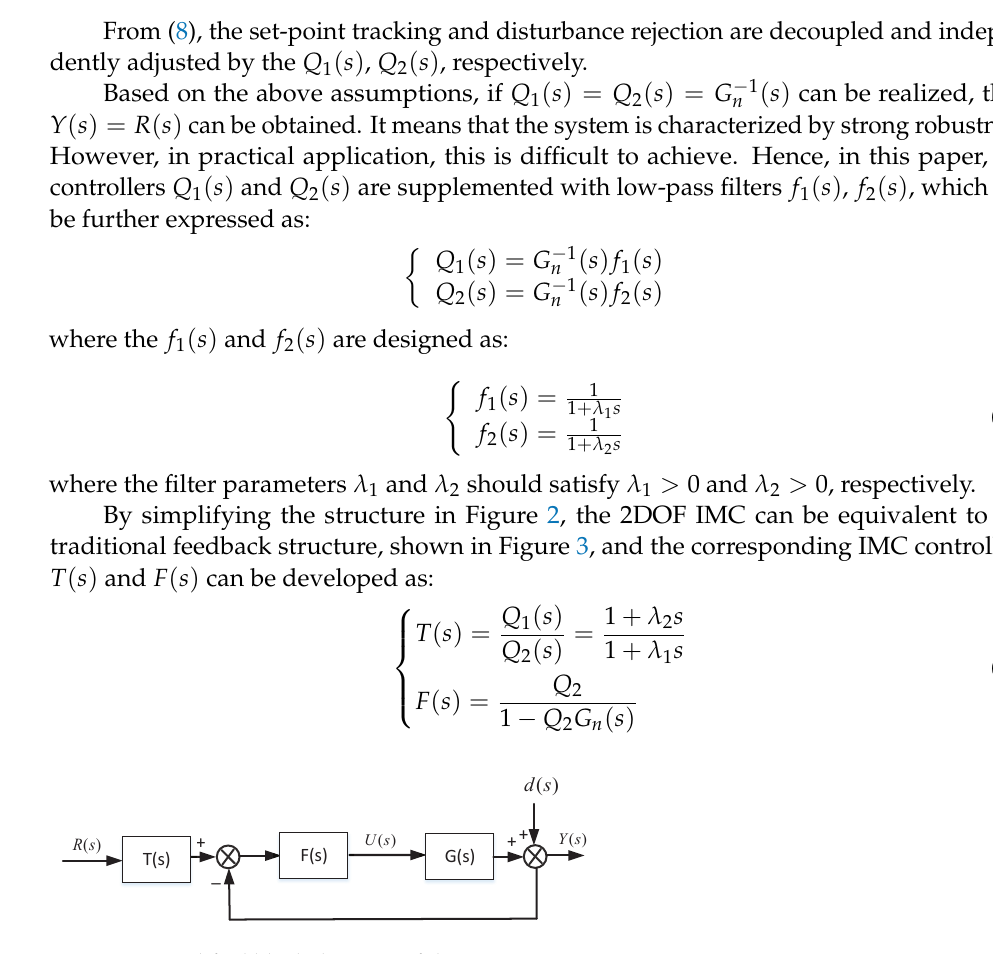
Figure 3. Simplified block diagram of the